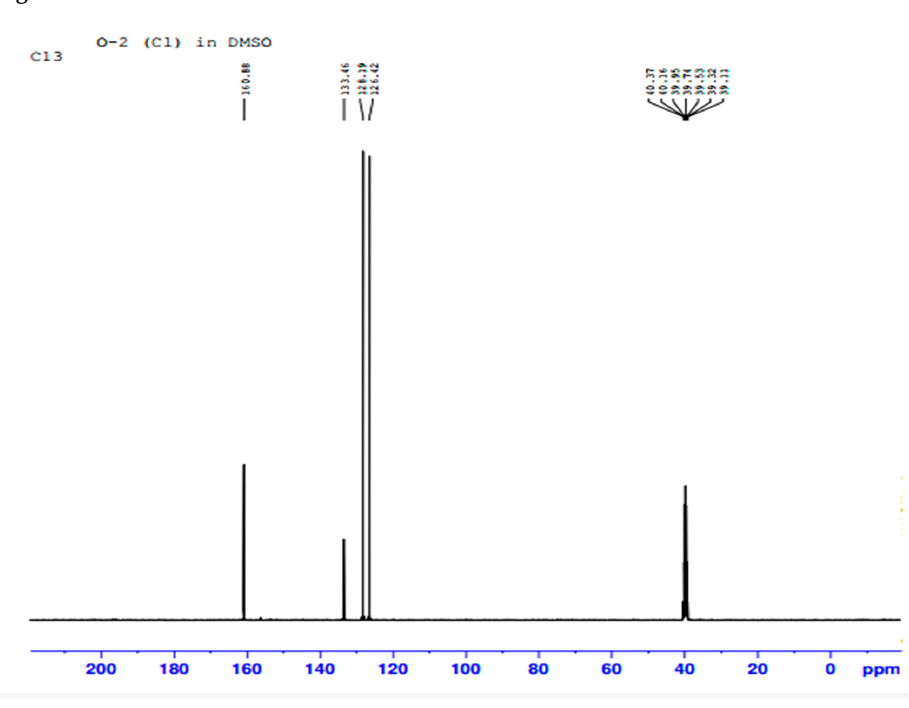
Figure 12. 13 C NMR of isolated metabolite.